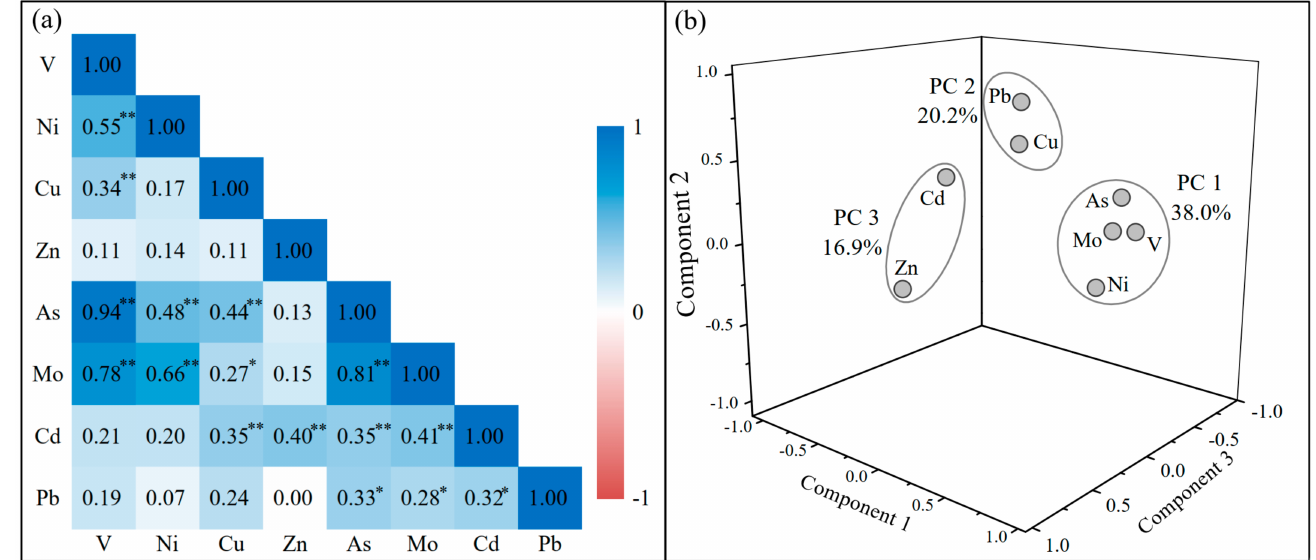
Figure 4. The correlation analysis ( a ) and principal component analysis ( b ) of eight HMs of river water in the upper TGR area. ** p < 0.01; * p <